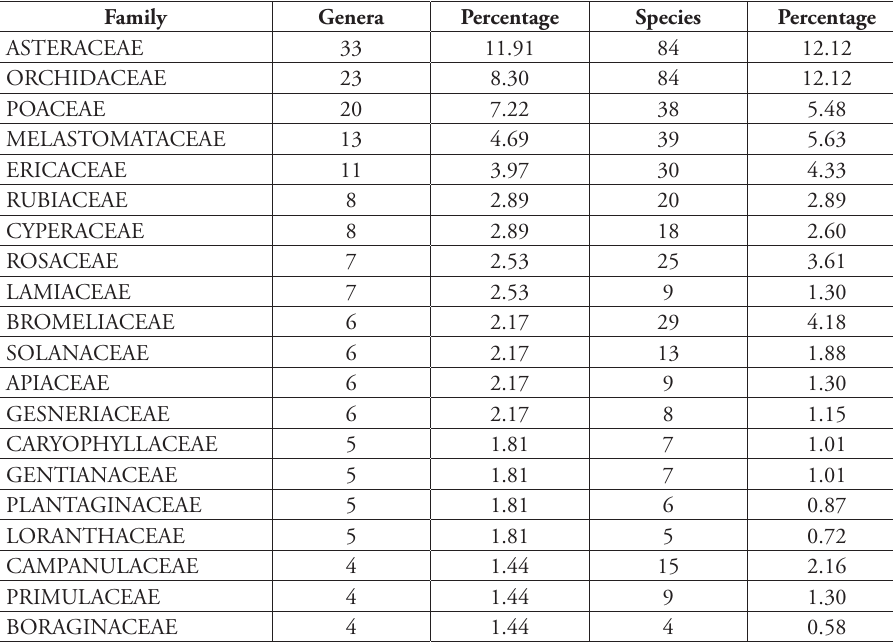
Table 2. Number of genera and species with their percentages for the 20 most diverse Angiosperm fami- lies in the páramos of